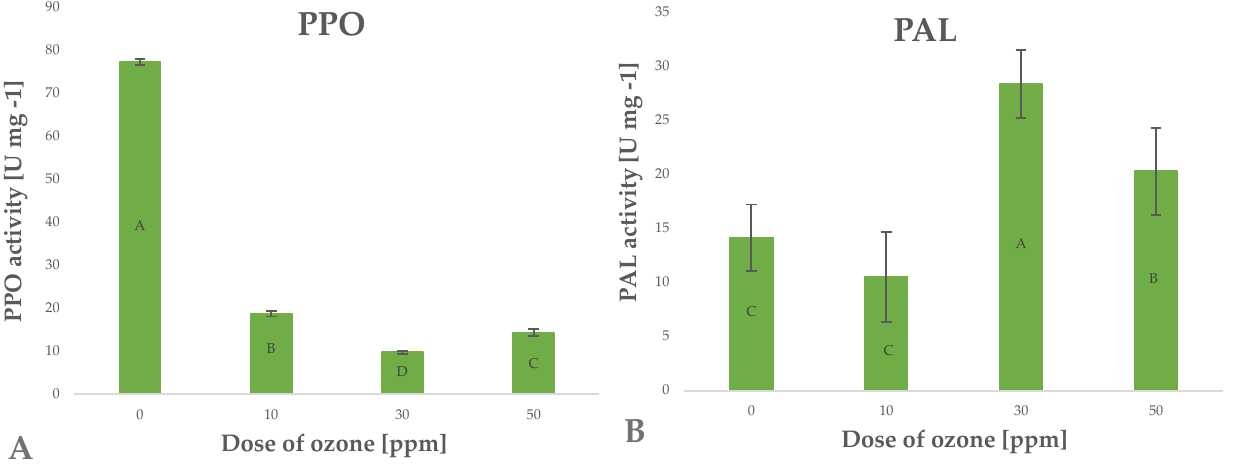
Figure 5. Polyphenol oxidase PPO ( A ) and phenylalanine ammonia lyase PAL ( B ) activity in barley young plants depending on the dose of ozone ( n = 20): differences between the results for the dose of ozone treatment are marked with capital letters; the significance level is defined as p < 0.05.